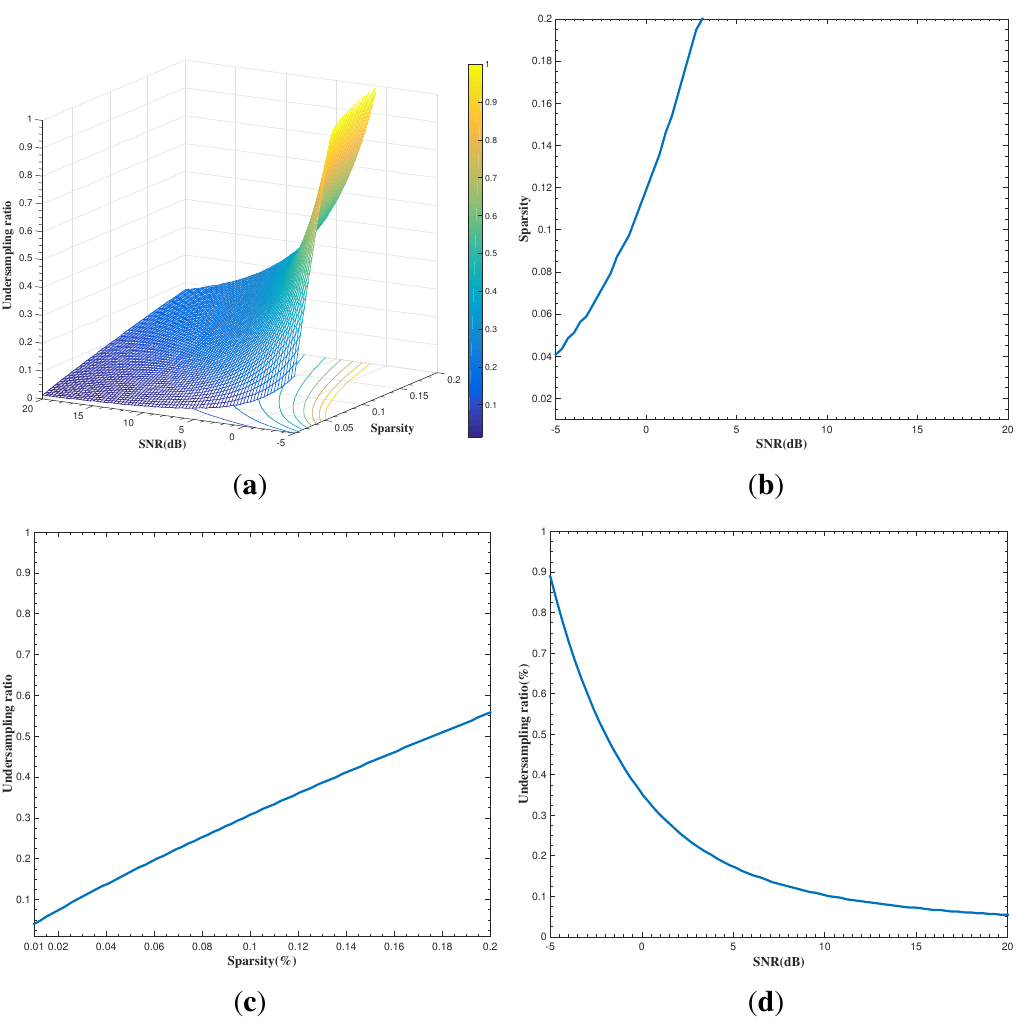
Figure 2. Information-theoretically-derived relationships among sparsity, SNR and undersampling ratios (distortion level = 0.01): ( a ) necessary undersampling ratios in relation to scene sparsity and SNR; ( b ) sparsity-SNR relationship with undersampling ratio = 75%; ( c ) sparsity-undersampling ratio relationship with SNR = 5 dB; and ( d ) undersampling ratio-SNR relationship with sparsity =